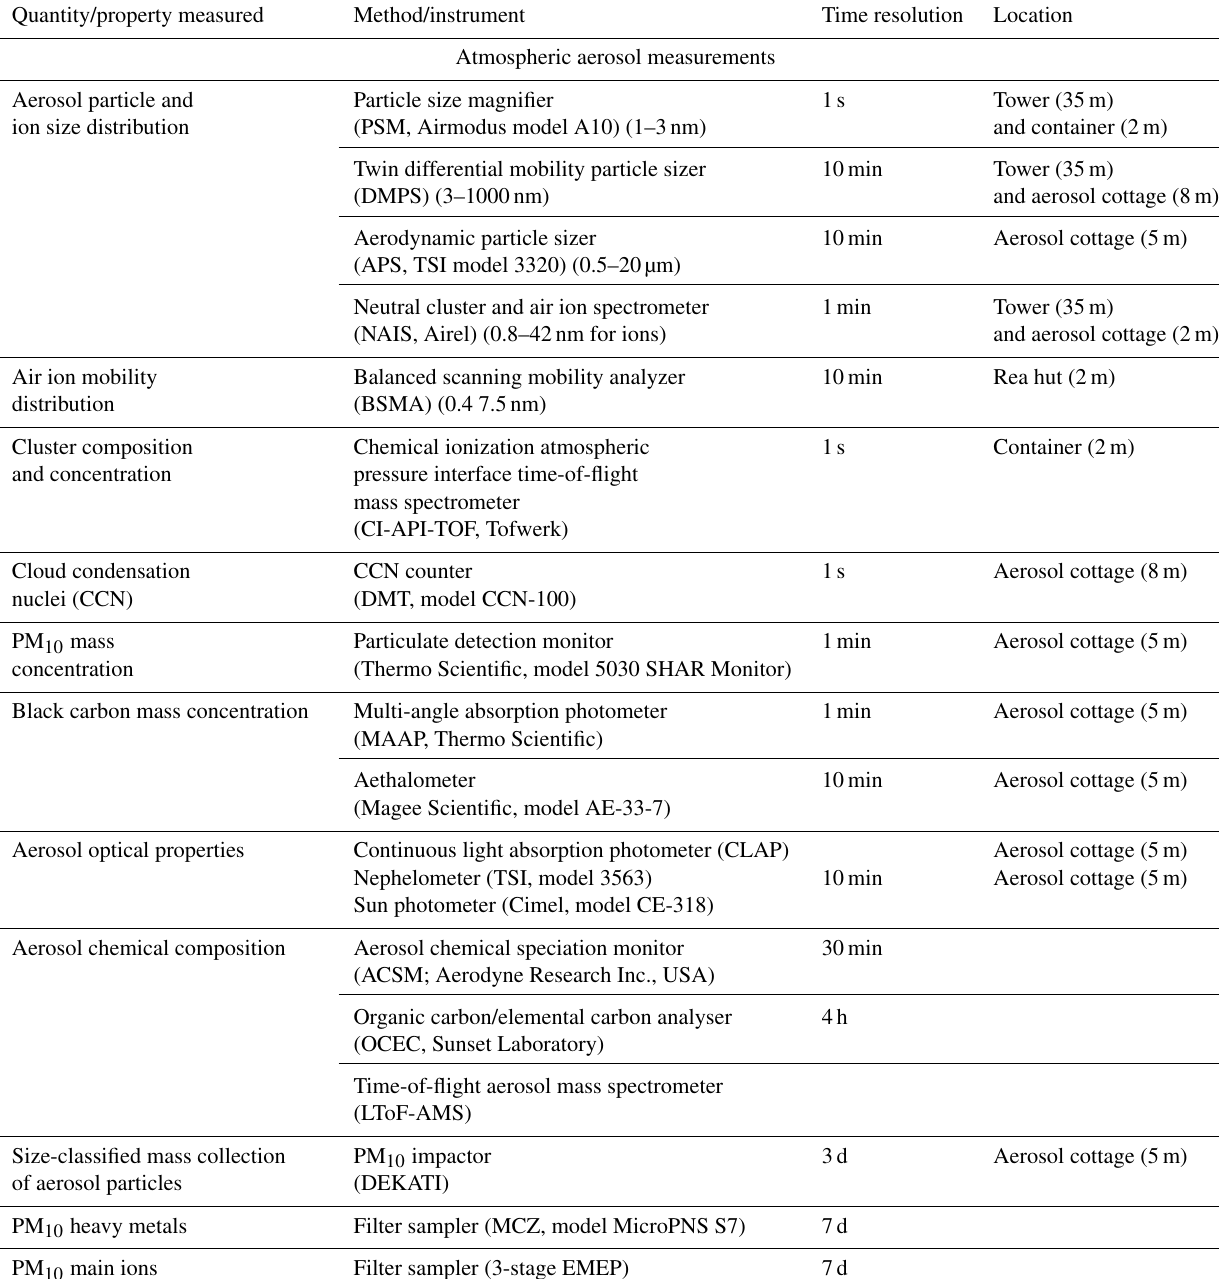
Table A1. Part 1: overview of the SMEAR II instrumentation running throughout the HyICE-2018